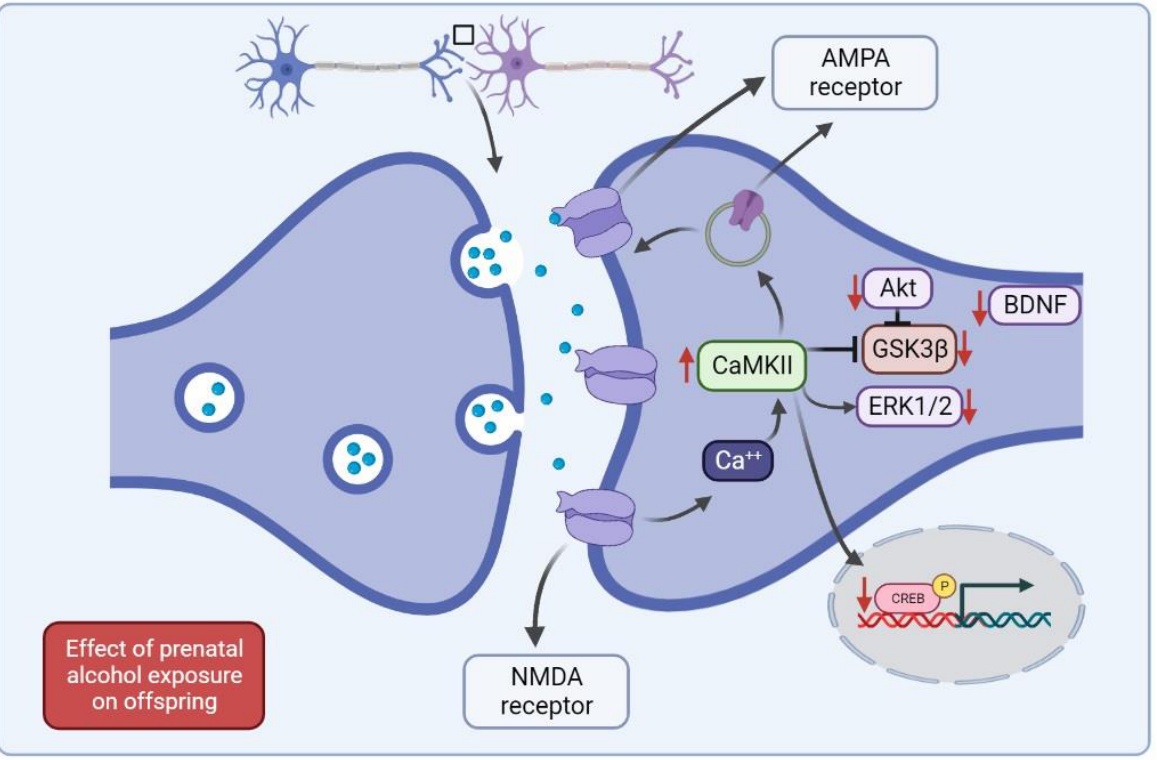
Figure 1. Diagrammatic representation of the cellular mechanisms of cognitive impairment induced by prenatal alcohol exposure. AMPA = α -amino-3-hydroxy-5-methyl-4-isoxazole propionic acid, NMDA = N -methyl-d-aspartate, CaMKII = calcium calmodulin dependent kinase II, Akt = protein kinase B, GSK3 β = glycogen synthase kinase 3 beta, ERK1/2 = extracellular regulated kinase 1 / 2 , BDNF = brain-derived neurotrophic factor, CREB = cAMP-response element binding protein. Akt is a downstream protein of phosphoinositide-3-kinase (PI3K), and the Akt/PI3K pathway functions as a prosurvival pathway [119]. Akt phosphorylation plays a key role